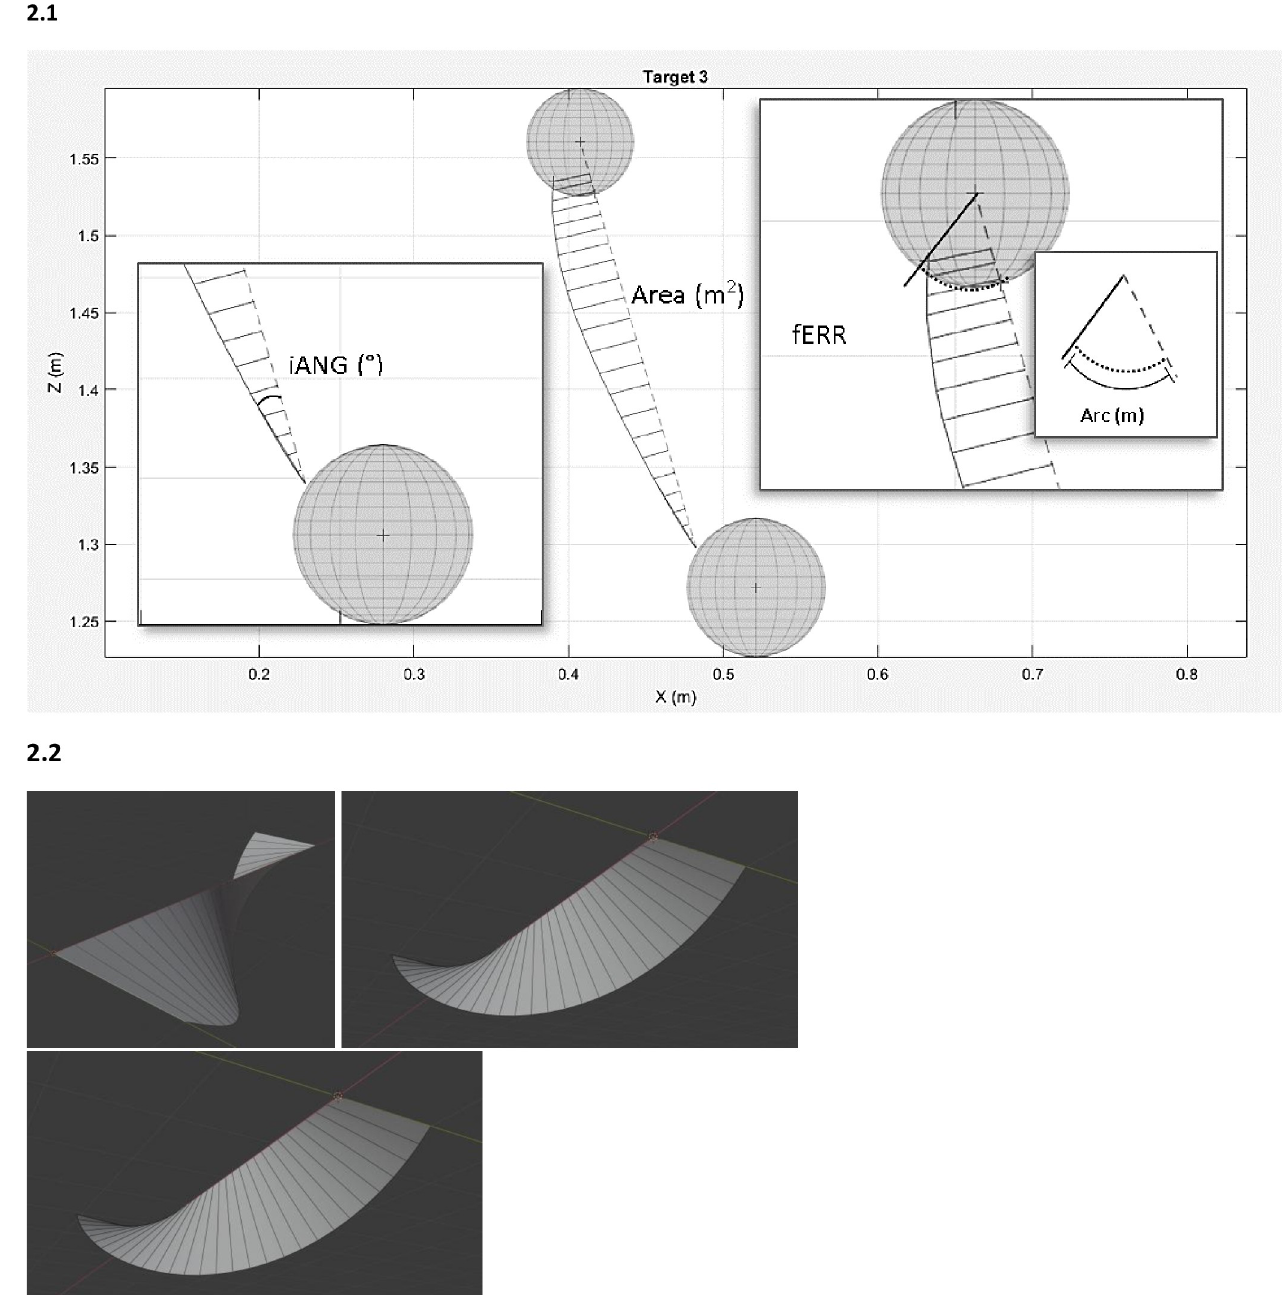
Fig 2. Spatiotemporal data collection. a. Example of spatiotemporal data collection while reaching target 3. iANG: initial angle of endpoint deviation, this angle was calculated using the shortest line between two targets [home and reaching targets] and the line corresponding to the initial peak of acceleration); fERR: final error, the shortest arc distance between the ideal arrival point into the sphere (target) and the actual arrival point. b. Example of a calculated 3D area under the curve for 1 reaching movement: the area under the curve is the summation of the rectangular trapezoids perpendicular to the ideal trajectory line and the actual trajectory